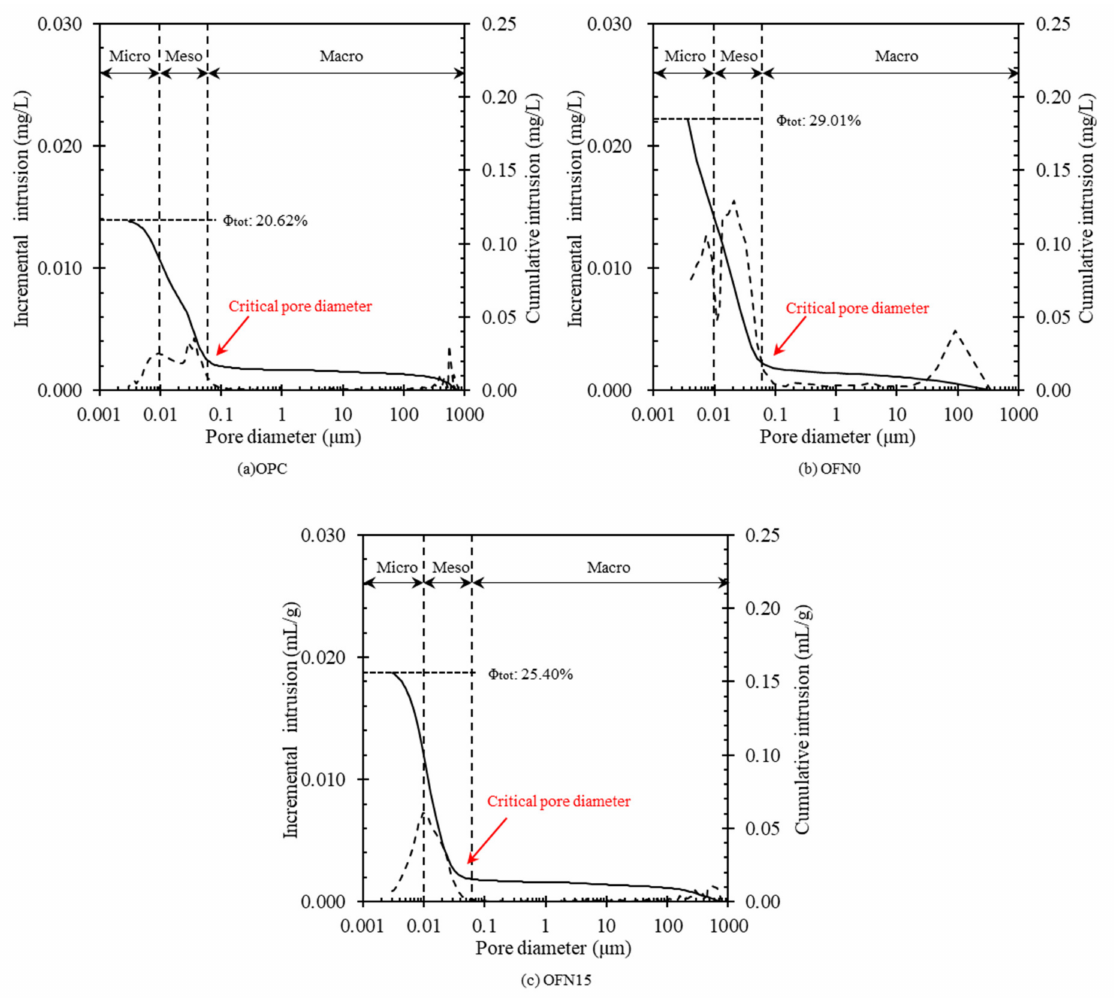
Figure 4. Pore distribution of paste for 365 days of curing; ( a ) OPC, ( b ) OFN0, ( c )